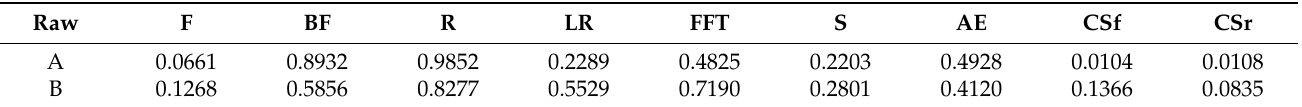
Table 3. Results of the randomness tests for the sequences from systems A and B. The tests are presented in terms of p -values. Denotations from the table refer to test names: Frequency, Block Frequency, Runs, Longest run, Fast Fourier Transformation, Serial, Approximate Entropy, Cumulative Sums forward, and Cumulative Sums reverse, respectively. The sequences of systems A and B used for the tests have a length of 10 million bits. p − value treshold =